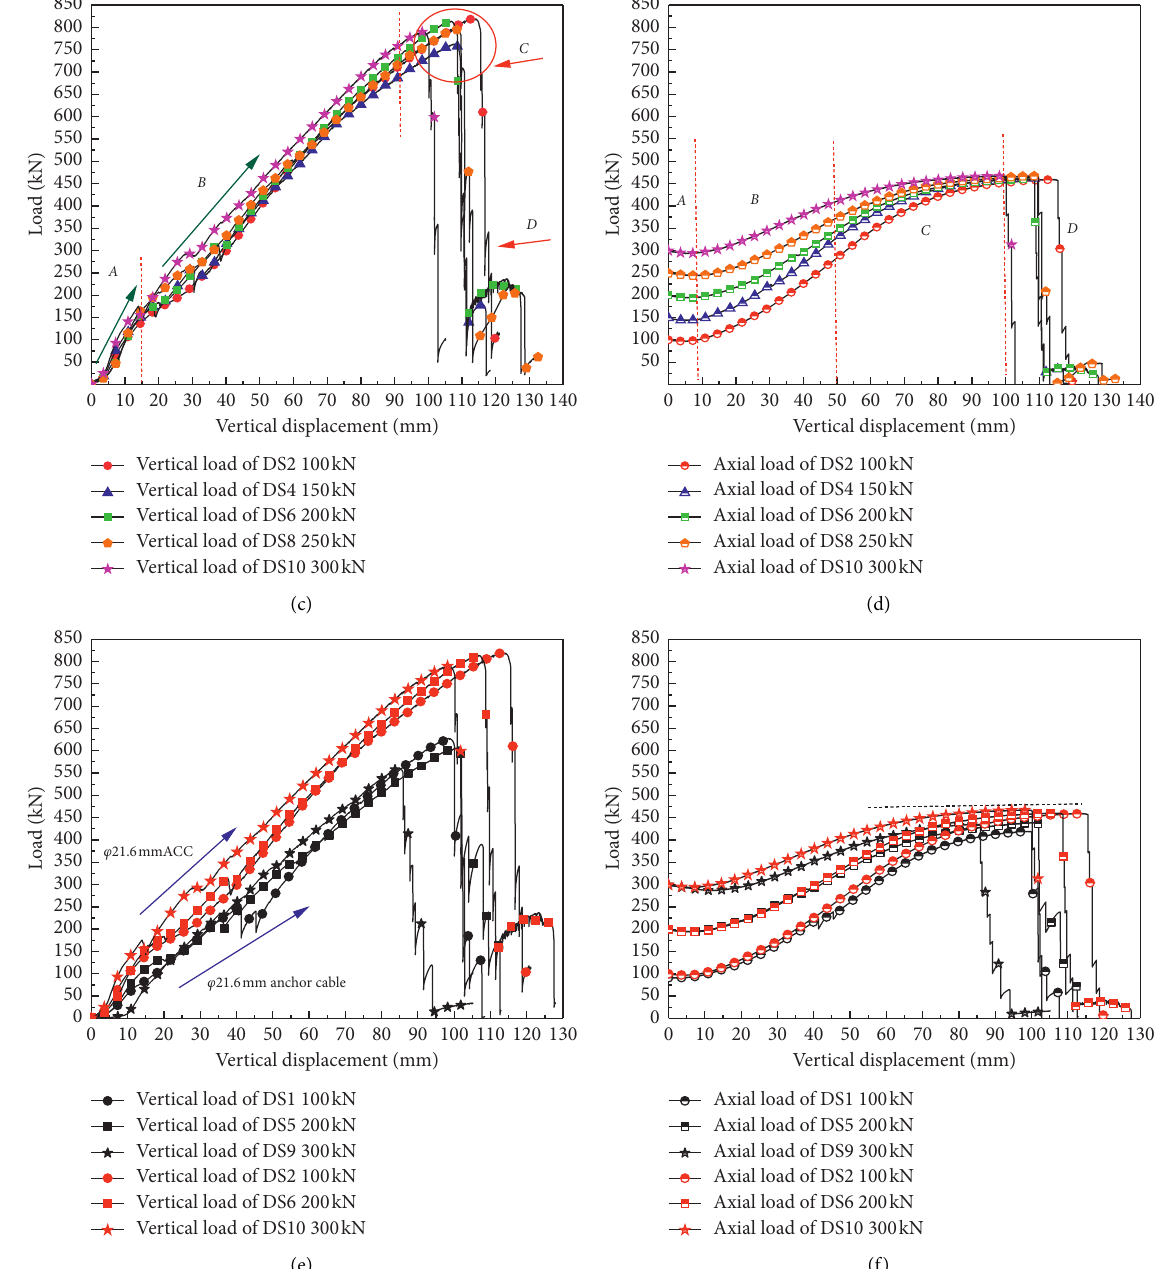
Figure 4: Data from the double-shear experiment. (a) Normal force displacement relationship of anchor cables with the diameter of 21.6mm. (b) Axial force displacement relationship of anchor cables with the diameter of 21.6mm. (c) Normal force displacement re- lationship of ACC with the diameter of 21.6mm. (d) Axial force displacement relationship of ACC with the diameter of 21.6mm. (e) Comparison of normal force displacement relationship between anchor cables with the diameter of 21.6 mm and the same type of ACC. (f) Comparison of axial force displacement relationship between the anchor cables with the diameter of 21.6 mm and the same type of